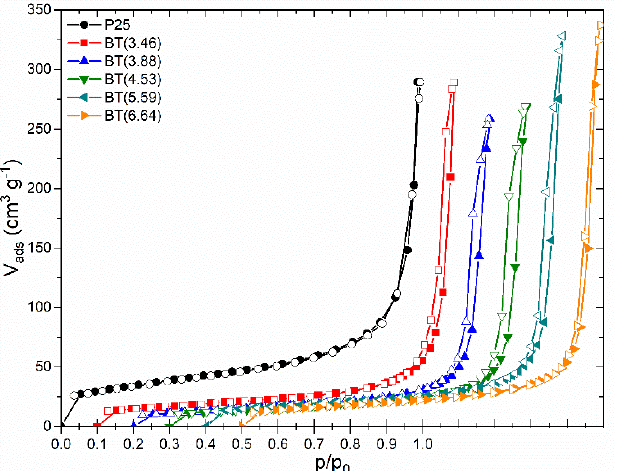
Figure 8. Experimental nitrogen adsorption/desorption isotherms of blue titania samples in comparison to P25. Isotherms were shifted by 0.1 along the p/p 0 axis for clarity.